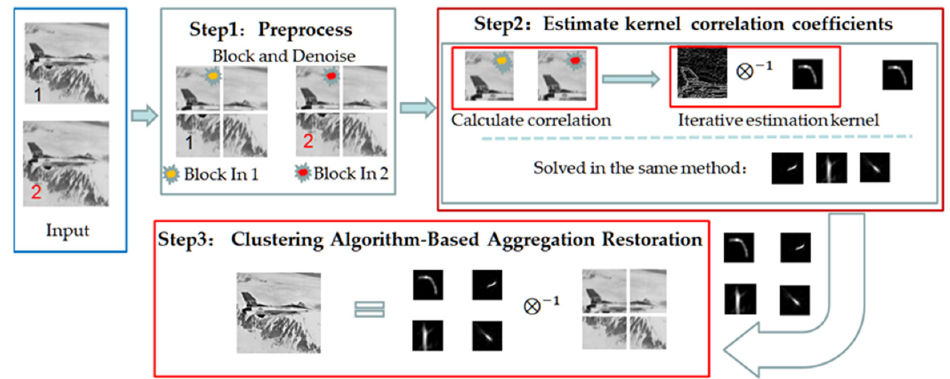
Figure 1. Structure flow chart: This figure describes the flow and components of the proposed algorithm. The input is two blurred images with different blurring patterns, but with the same object. The first step is pre-processing, which focuses on block splitting and de-noising. The second part estimates the blur kernel, block by block. The third step is the classification of the blur kernels using a clustering algorithm and the final restoration.